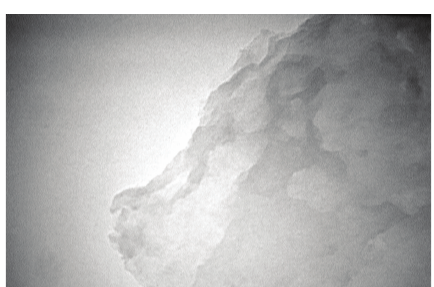
Figure 2: TEM image of graphene oxide (GO) sheets illustrating their flake-like shape.